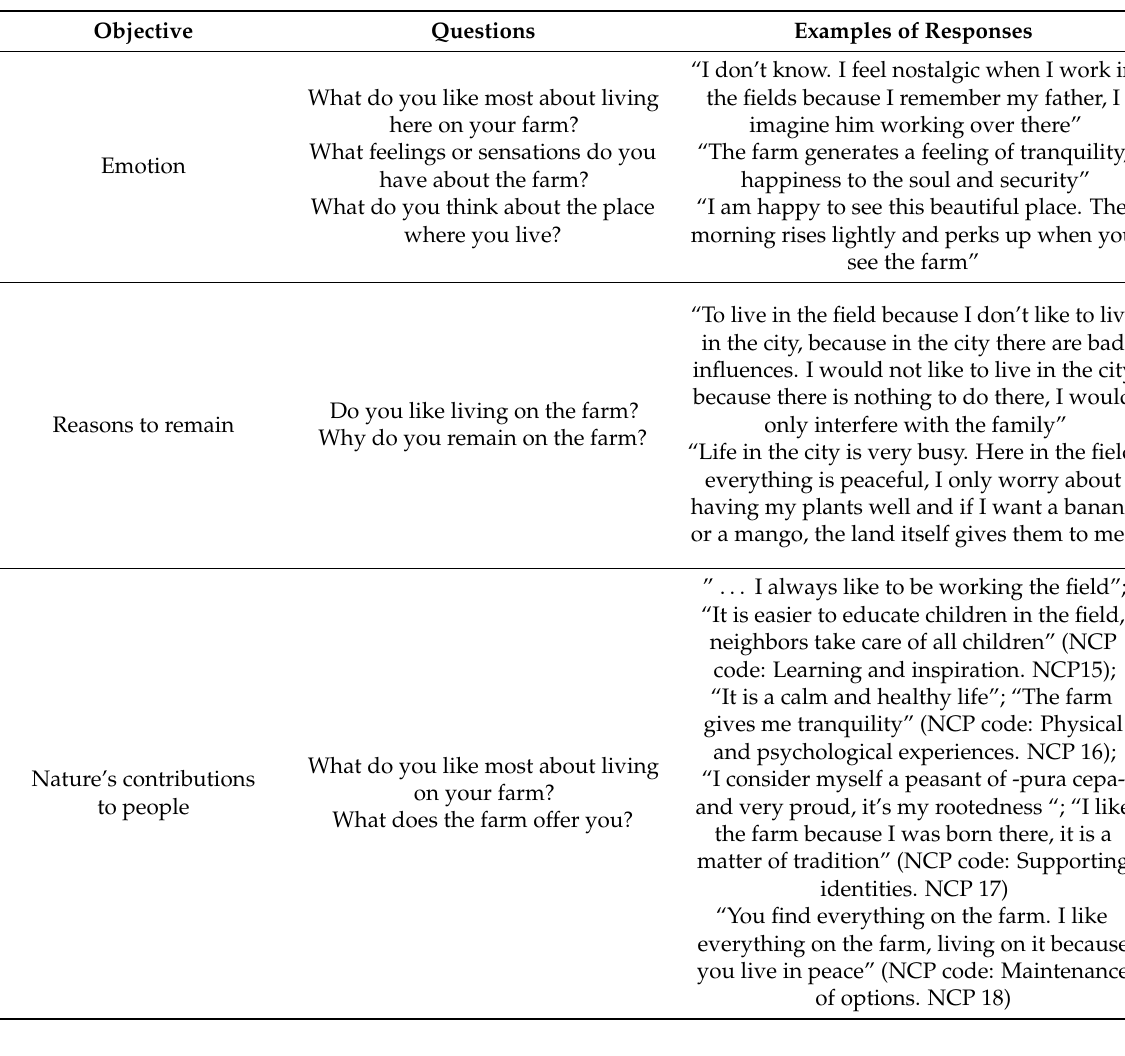
Table A2. Questions, quotes and